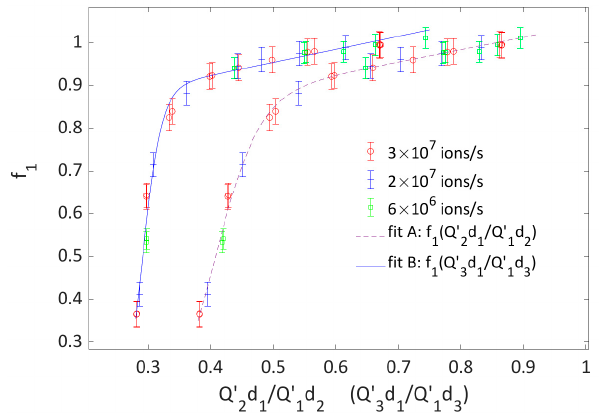
Figure 6. Calibration curves measured for chamber 1 as a function of Q (cid:2924)(cid:4593) d 1 / Q (cid:2869)(cid:4593) d n . The fit A describes the results achieved using data from chamber 1 and chamber 2, while fit B describes the data from chamber 1 and chamber 3. The color indicates the beam intensity.